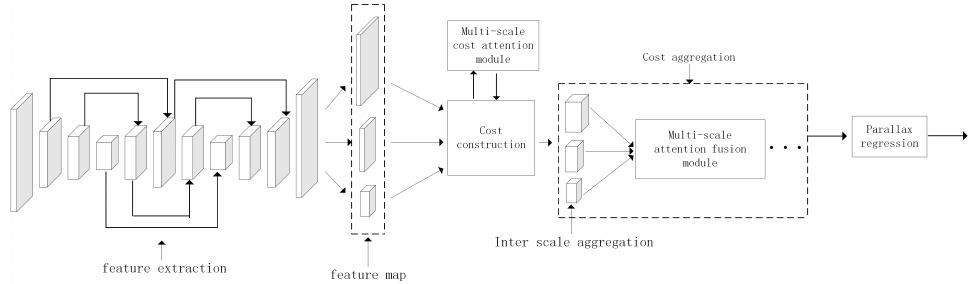
Figure 1. Stereo matching network with multi-scale cost attention and self-use fusion.